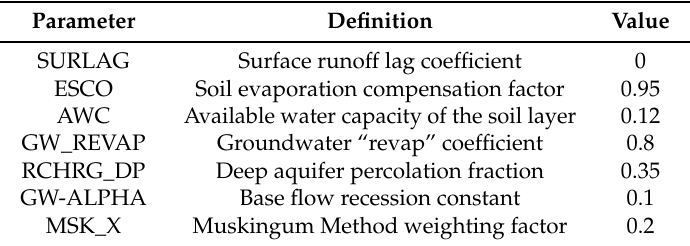
Table 1. Main parameters of watershed hydrological model.